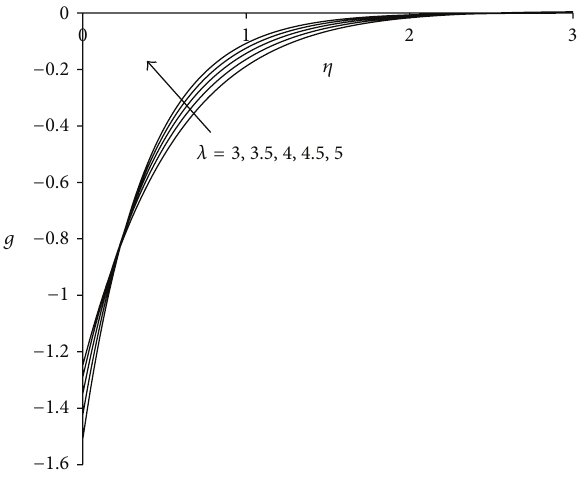
Figure 3: Microrotation distribution for different 𝜆 (𝜏 = 1,𝜎 = 3, Ec = 0.75)